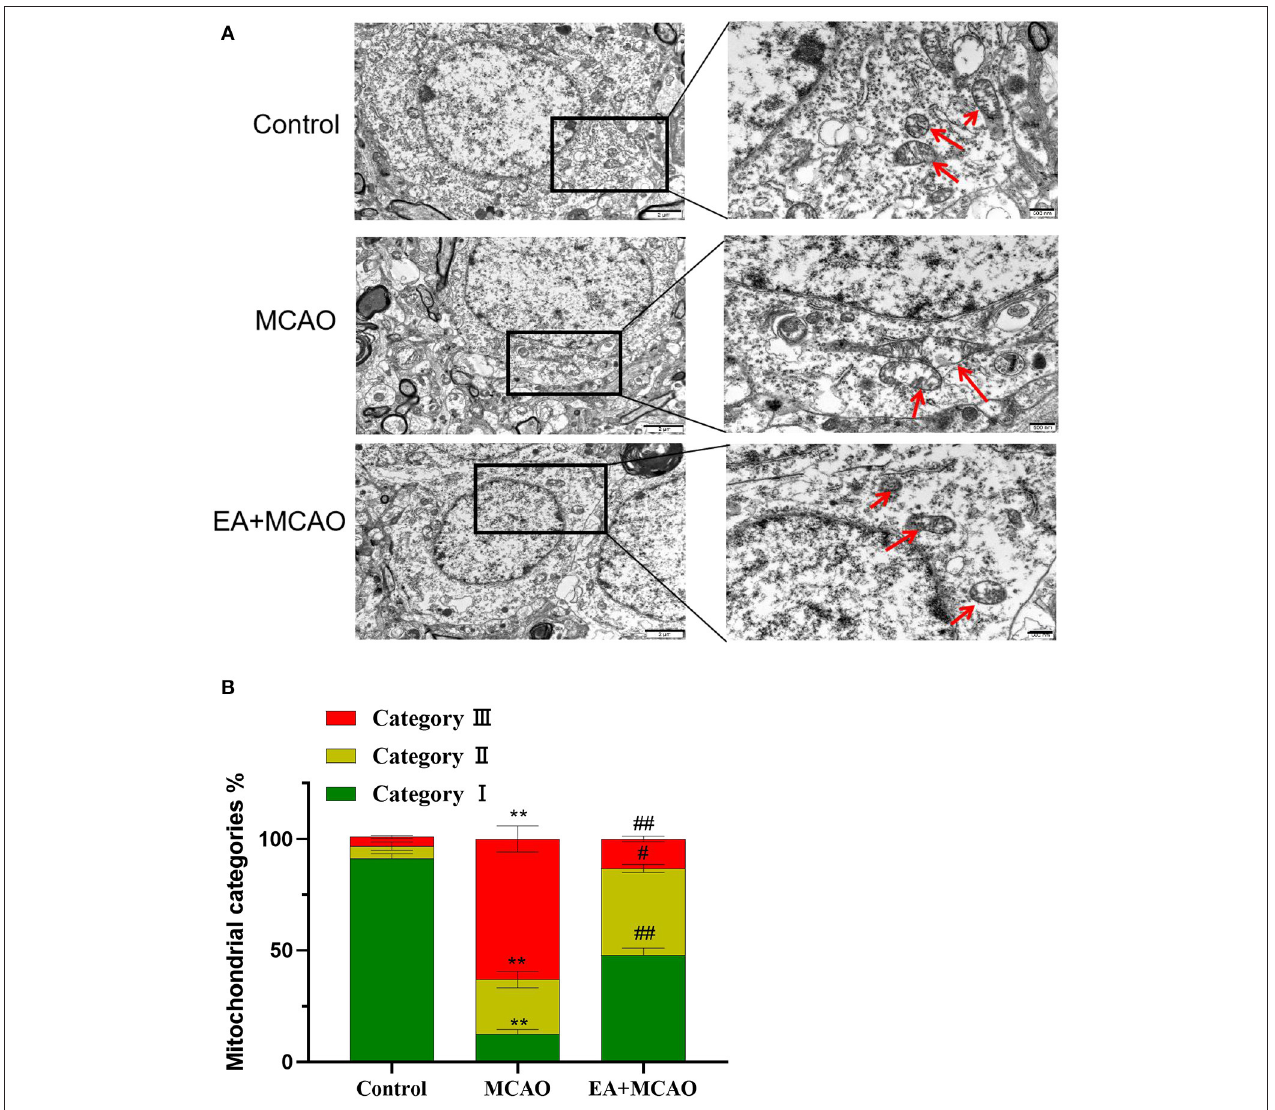
FIGURE 5 | Electroacupuncture protects neuronal mitochondria. (A) TEM images of cortical cerebral tissues from each group. Scare bars: left, 2 µ m; right, 500nm. (B) Quantification of mitochondria counted blind to intervention of condition of three independent experiments. Results are expressed as means ± SEM. ** P < 0.01, compared with the Control group; # P < 0.05, and ## P < 0.01, compared with the MCAO